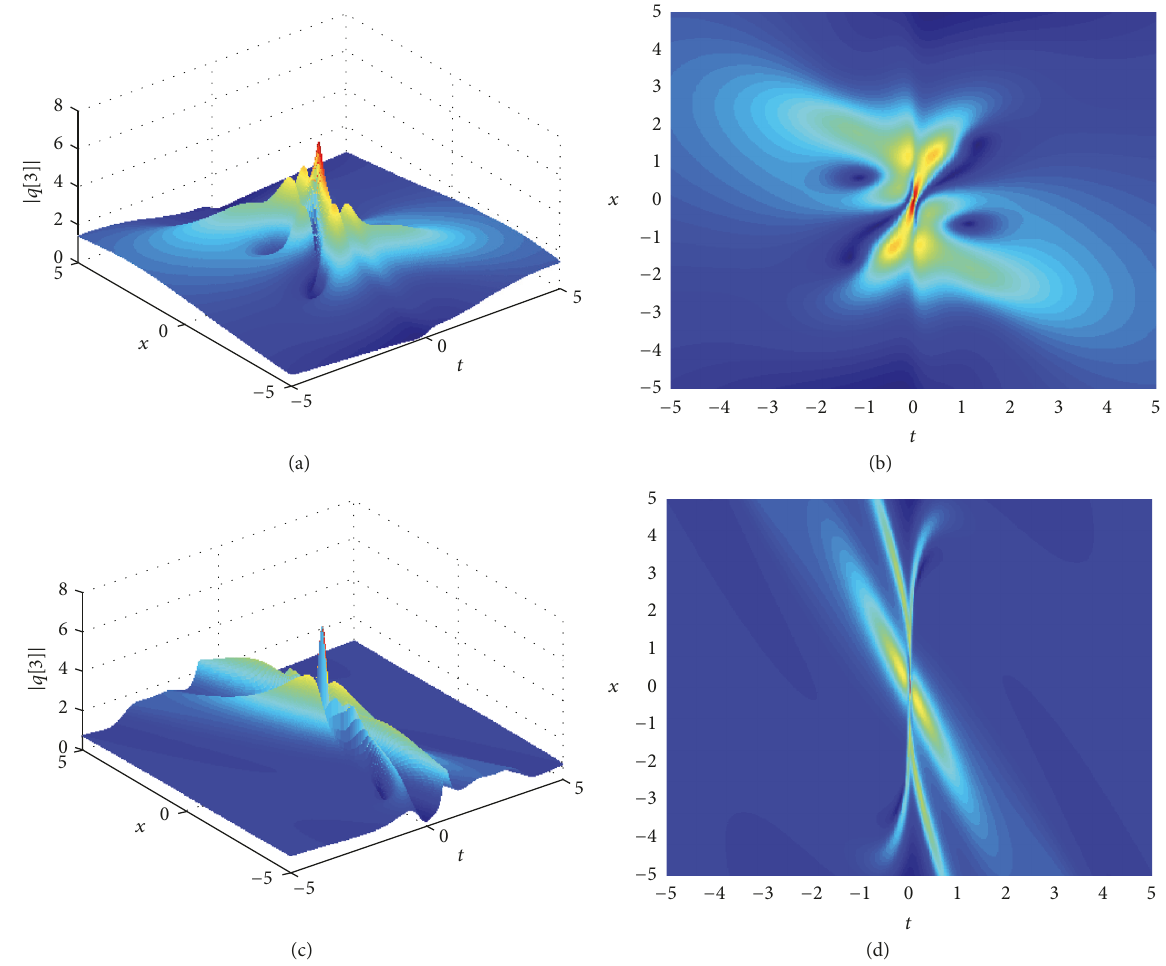
Figure 4: (a) The third-order rogue wave with 𝜀 = 0 , 𝑎 1 = 𝑏 1 = 0 , and 𝑎 2 = 𝑏 2 = 0 ; (b) the density plot with 𝜀 = 0 , 𝑎 1 = 𝑏 1 = 0 , and 𝑎 2 = 𝑏 2 = 0 ; (c) the third-order rogue wave with 𝜀 = 0.5 , 𝑎 1 = 𝑏 1 = 0 , and 𝑎 2 = 𝑏 2 = 0 ; (d) the density plot with 𝜀 = 0.5 , 𝑎 1 = 𝑏 1 = 0 , and 𝑎 2 = 𝑏 2 = 0 .